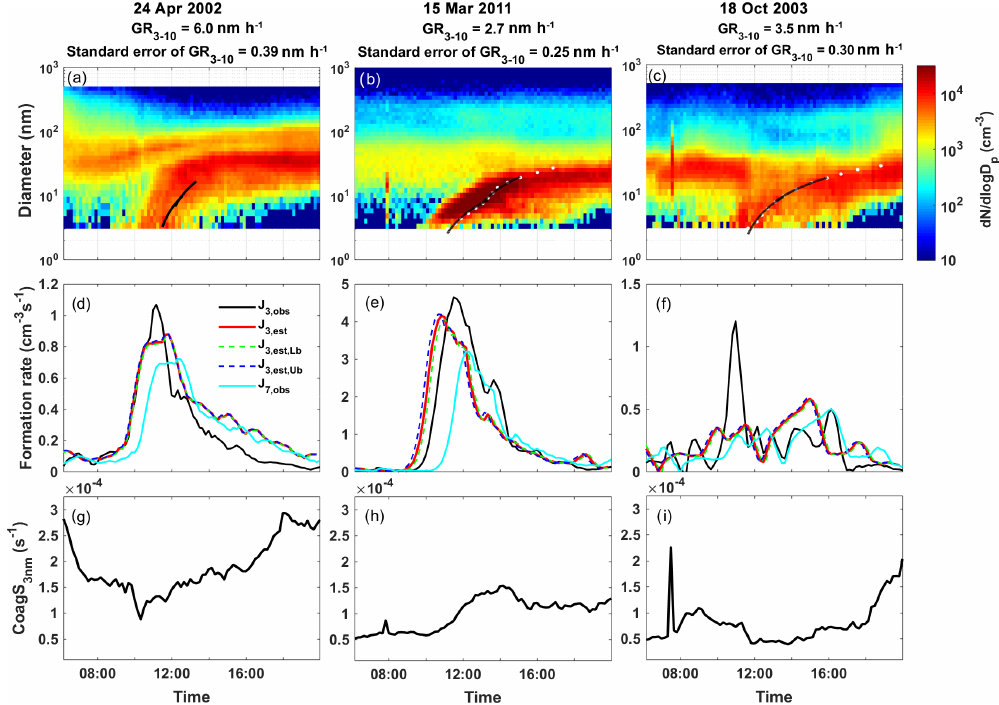
Figure 2. Examples of Hyytiälä NPF events. (a, b, c) the evolution of the particle number size distribution. White dots represent the times of the maximum concentration in each size bin of the measured size distribution, and the solid black line shows the first-order polynomial fit to those data points. (d, e, f) The corresponding time evolution of 3nm particle formation rates J 3 , obs obtained from Eq. (2) (black line), observed formation rates of 7nm particles J 7 , obs obtained from Eq. (3) (cyan line), and the estimated formation rate of 3nm particles J 3 , est calculated by Eq. (4) (red line). The dashed lines show the upper bound ( J 3 , est , Ub ) and lower bound ( J 3 , est , Lb ) calculated by Eq. (4) using the lower (GR 3–10 – SE) and upper (GR 3–10 + SE) bound of GR 3–10 , respectively. (g, h, i) The time evolution of the coagulation sink of 3nm particles.